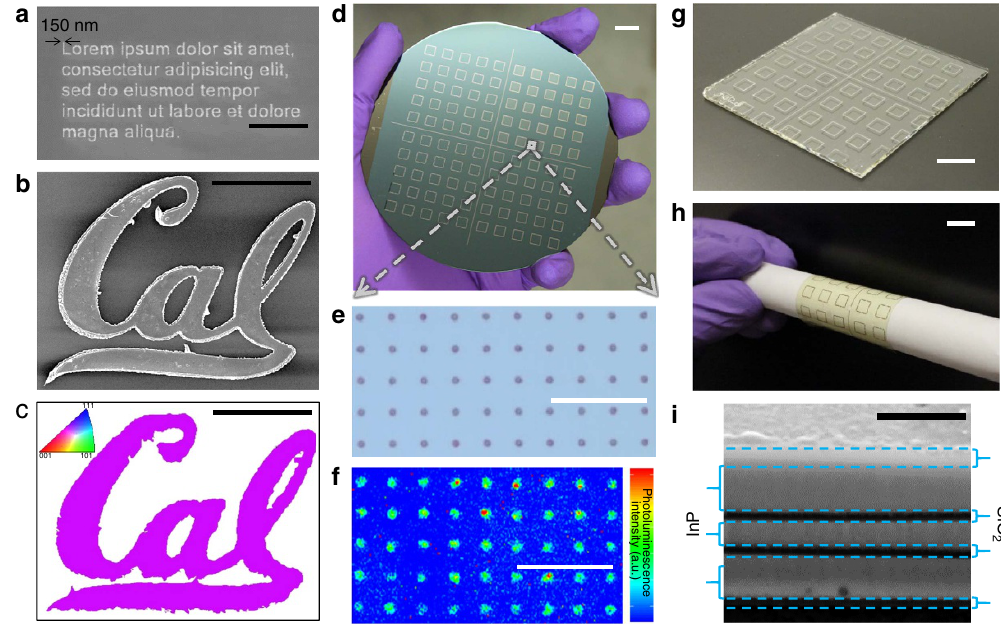
Figure 2 | Scalability and growth on ‘novel’ substrates. ( a ) SEM image of InP text with a linewidth of 150nm. Scale bar, 3 m m. ( b ) An SEM image and corresponding ( c ) EBSD map of a single-crystalline UC Berkeley ‘ Cal ’ logo grown via TLP crystal growth. Scale bar, 30 m m. The Cal script logo is a federally registered trademark and may not be used without permission of The Regents of the University of California. ( d ) An optical image of a 4-inch Si/SiO 2 wafer patterned with arrays of 3 m m diameter InP dots located within each square InP box. Scale bar, 1cm. ( e ) Zoomed in optical image of an array of dots on the wafer and ( f ) their corresponding photoluminescence image. Scale bar, 50 m m. ( g ) An optical image of patterned InP dots grown on a B 6 (cid:2) 6cm borosilicate glass slide. Scale bar, 1cm. ( h ) An optical image of the patterned InP dot array transferred onto a PETsubstrate wrapped around a glass tube with a diameter of 1.5cm. Scale bar, 1cm. ( i ) Cross-sectional SEM image of three layers of InP grown with 30nm of SiO x between each layer. Scale bar,